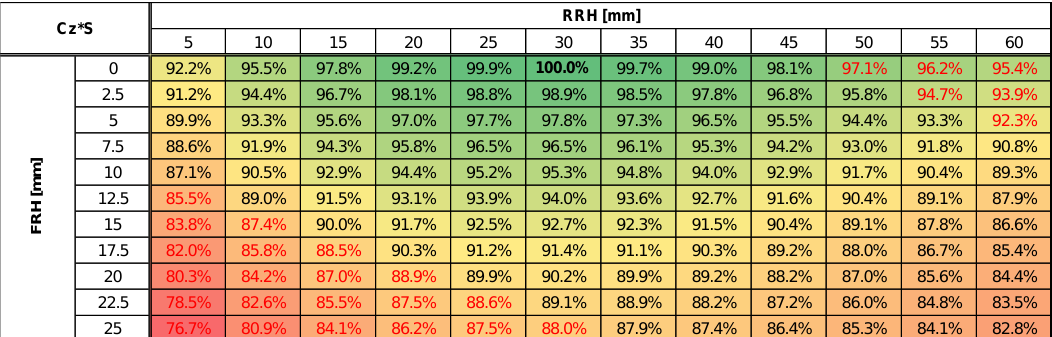
Figure 6. Drag coefficient C D S vs. Front Ride Height FRH and Rear Ride Height RRH. Actual figures are not shown for confidentiality reasons. The percentage variation is computed with reference to maximum drag. Also shown are the ride height ranges: the front one is lower on average and narrower than the rear. Cells with values in red are the areas less likely to tap into: high nose and low tail (high FRH/low RRH, bottom left) and very low nose, high tail (low FRH/high RRH, top right). Background colors highlight the C D S trend: red is the worst (highest) drag zone, while green is the lowest.